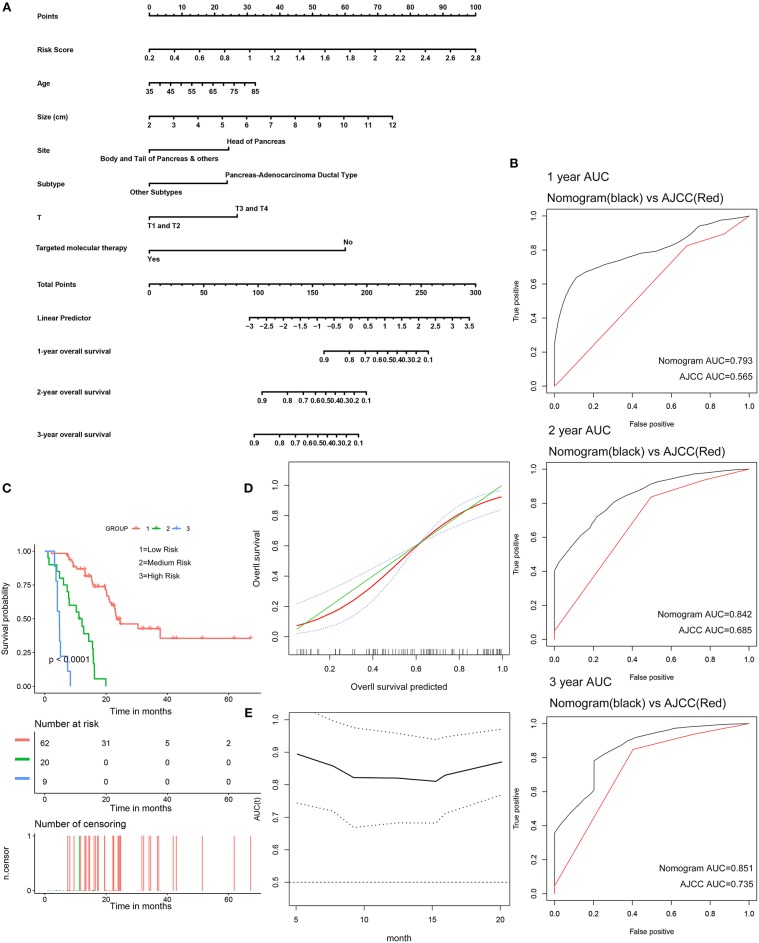
Validation of the nomogram in predicting overall survival of pancreatic cancer in the TCGA dataset. (A) A prognostic nomogram predicting 1-, 2-, and 3-year overall survival of pancreatic cancer. (B) Shows the time-dependent ROC for 1-, 2-, and 3-year overall survival predictions for the nomogram in compare with AJCC stage. (C) Shows the Kaplan-Meier survival curves of the nomogram. Patients from the TCGA dataset are stratified into three groups according to the optimal cutoffs for the nomogram calculated by X-Tile. (D) The calibration plot for internal validation of the nomogram. The Y axis represents the actual overall survival while the X axis represents the predicted overall survival. (E) The time dependent AUC of the nomogram in predicting overall survival of pancreatic cancer.